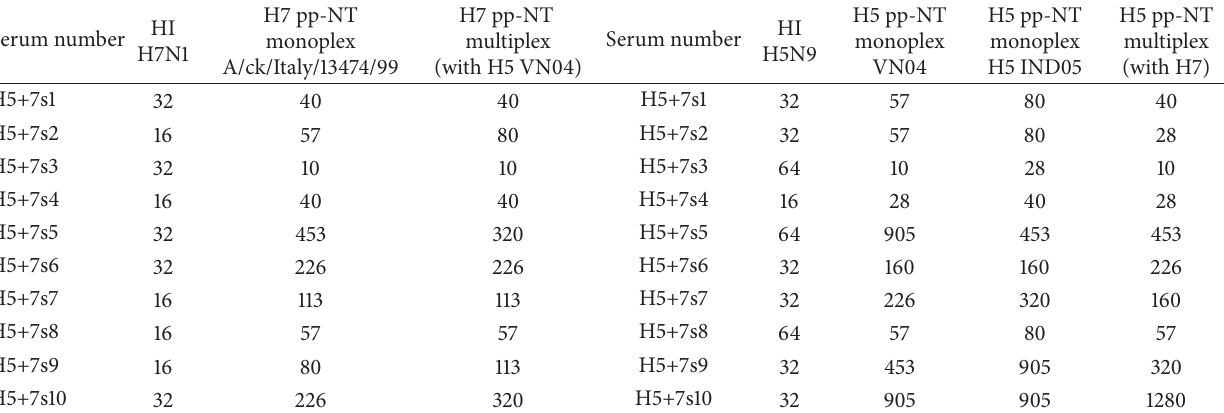
Table 3: Evaluation of antibody responses in sera collected from chickens vaccinated with a bivalent vaccine (H5/H7) by using the monoplex and multiplex assay formats.